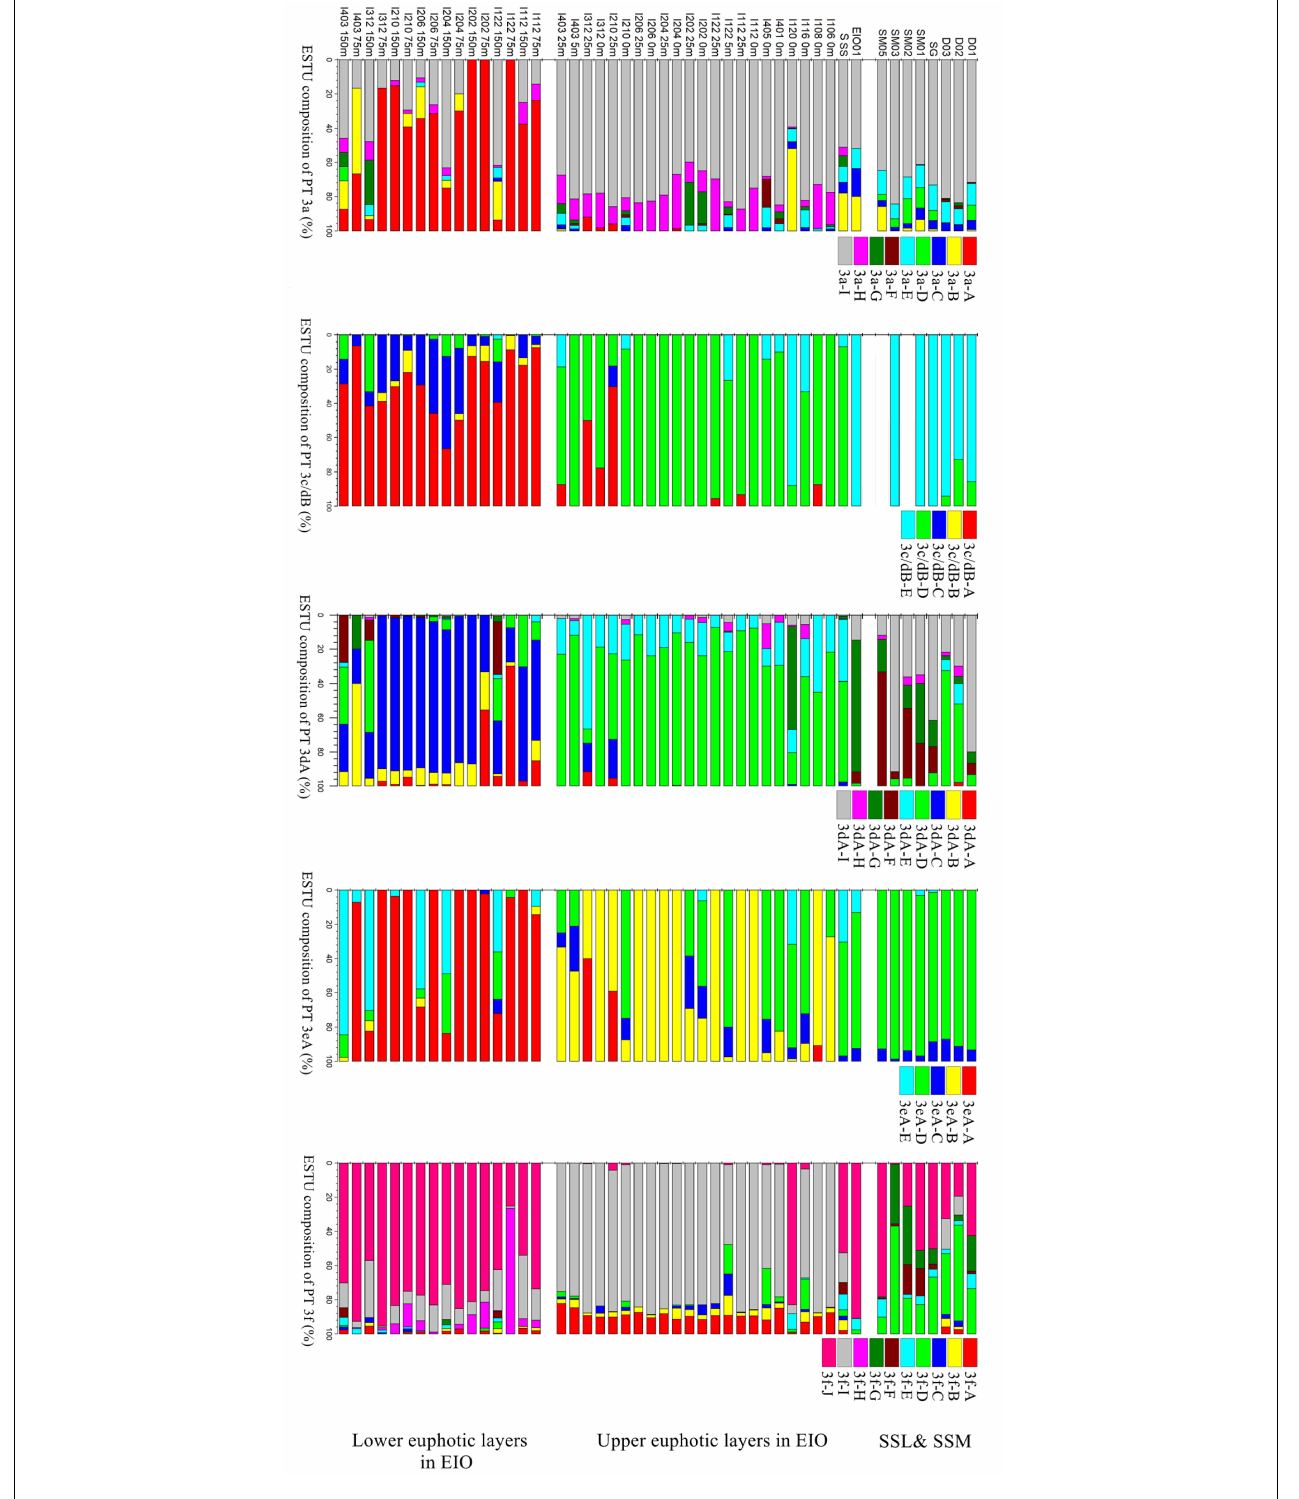
FIGURE 7 | Divergence of different ecologically significant taxonomic units (ESTUs) within each PT in surface water of coastal waters of Sri Lanka (SSL), the Strait of Malacca (SSM), and the upper and lower euphotic layers in eastern Indian Ocean (EIO).